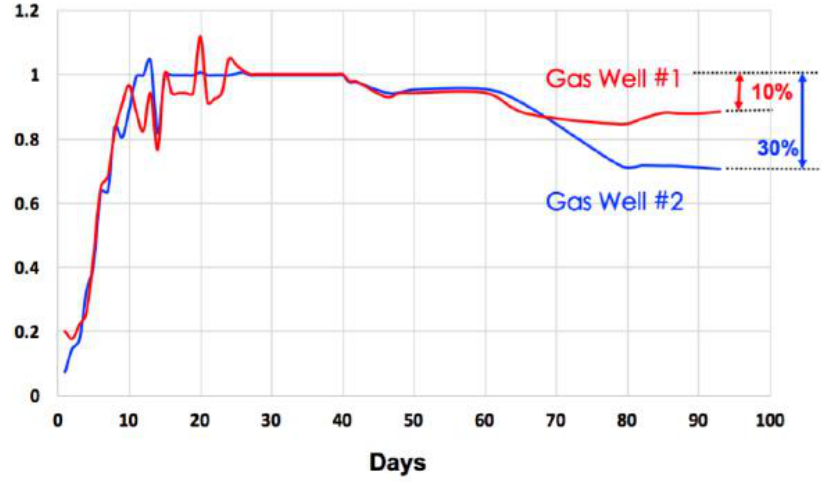
Figure 19—Gas production rate: Less-damaging FR (red) vs. conventional FR